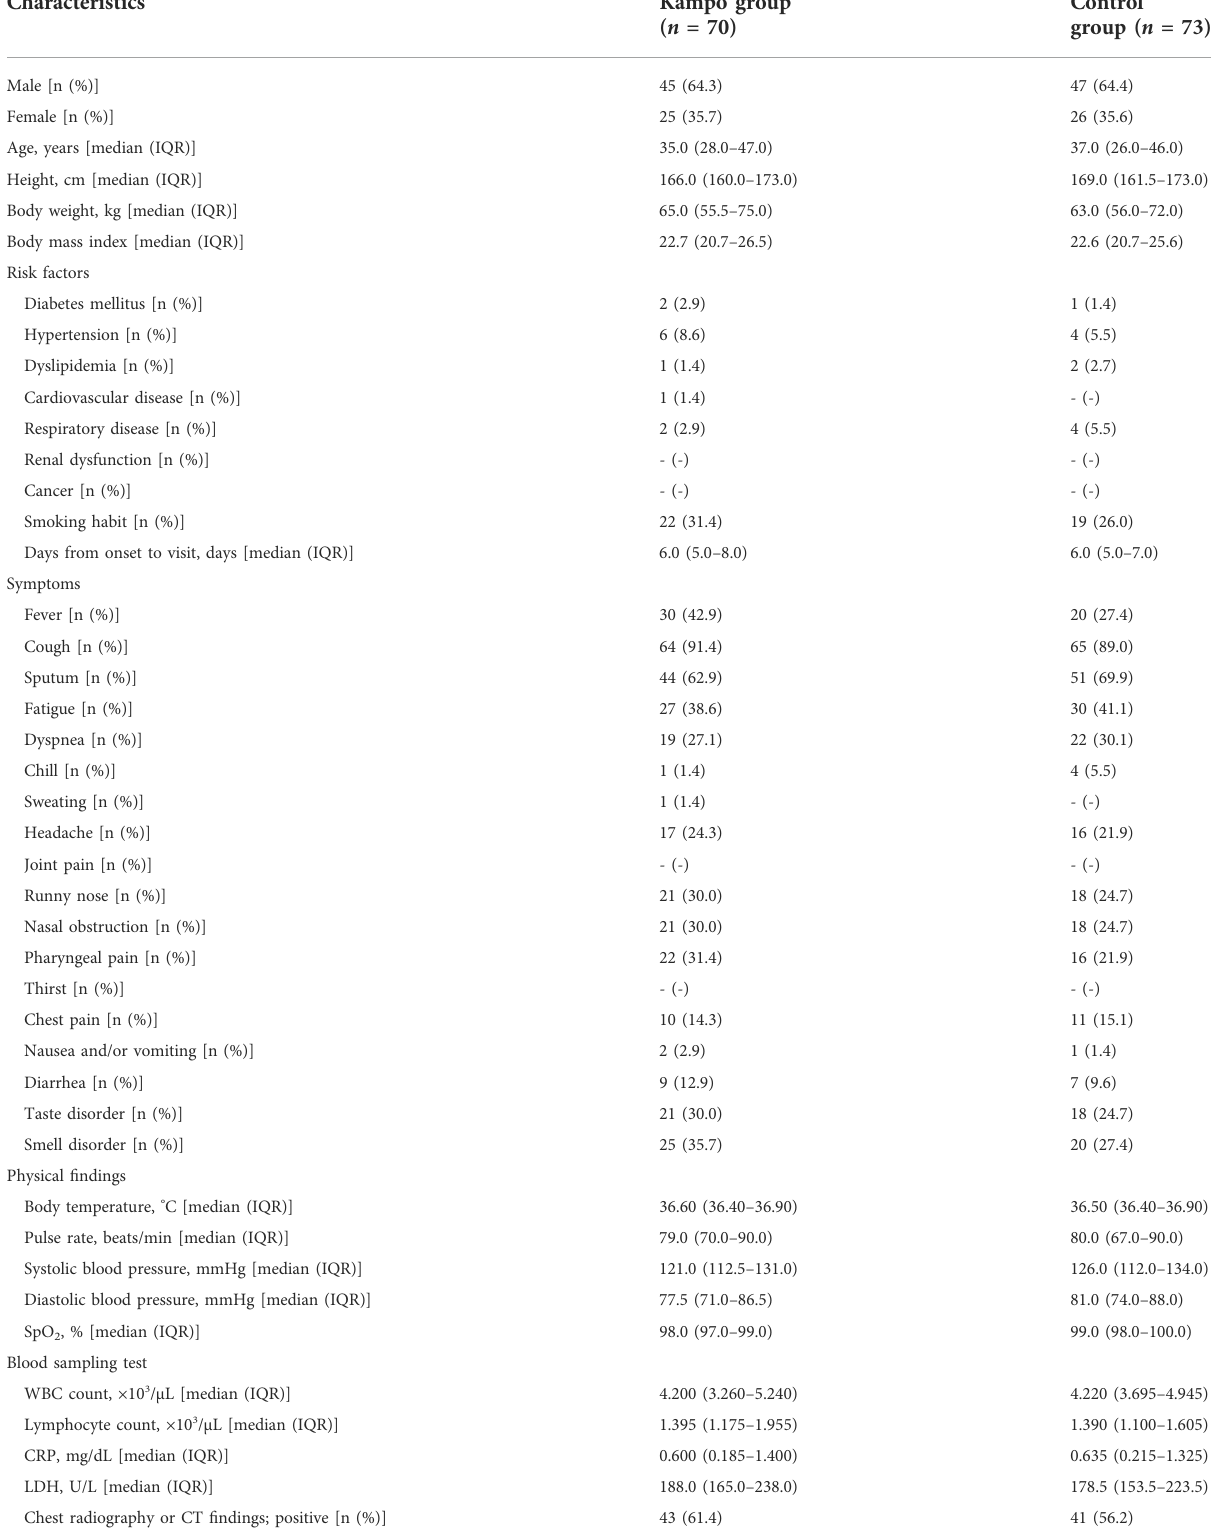
TABLE 1 Demographic and characteristics of the patients at